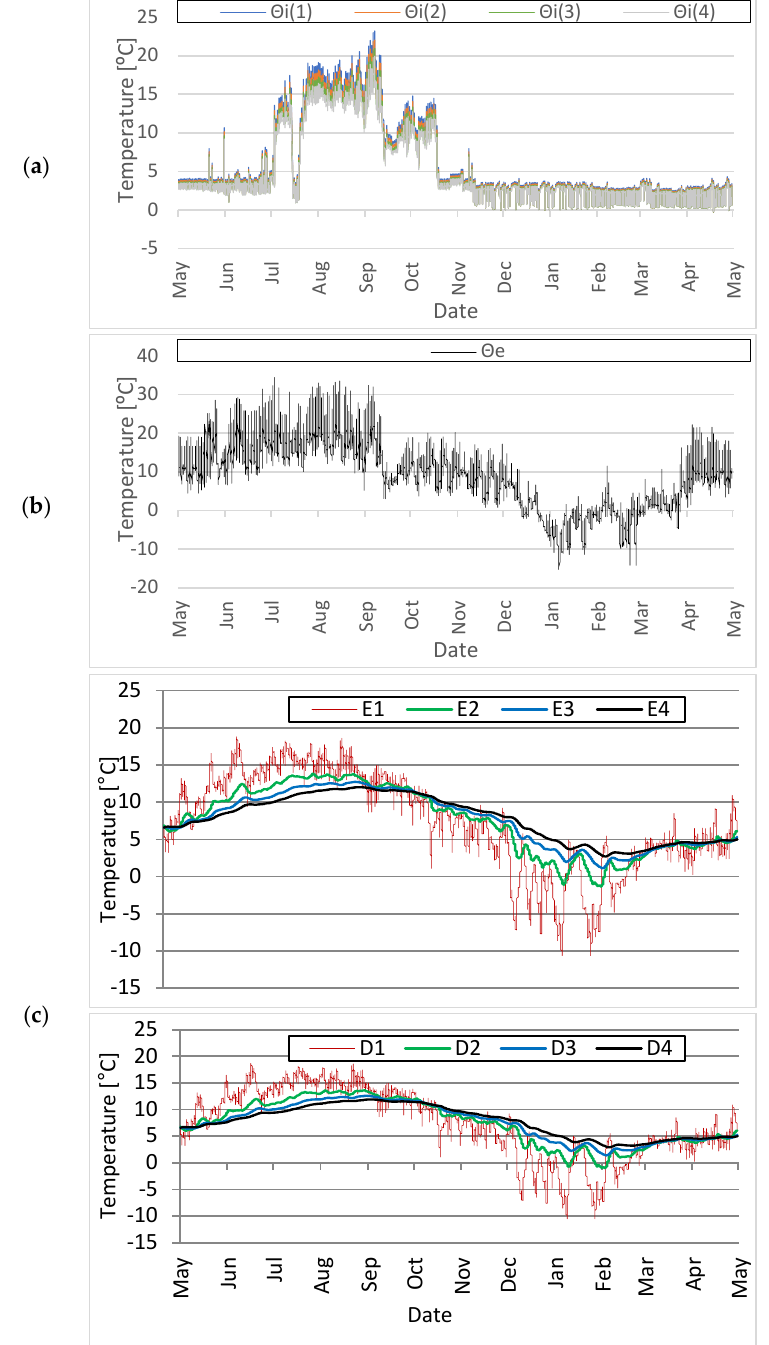
Figure 4. The course of the measured temperature of the indoor air ( a ) and outdoor air ( b ) and the temperature of the ground in measurement points E1–E4 and D1–D4 ( c ). The analysis of the validation results showed a very strong correlation of measure ‐ ment and theoretical data (0.88–0.95). There were no statistically significant differences ( p < 0.05) between the measurement data and those obtained as a result of calculations (Fig ‐ ure 5).